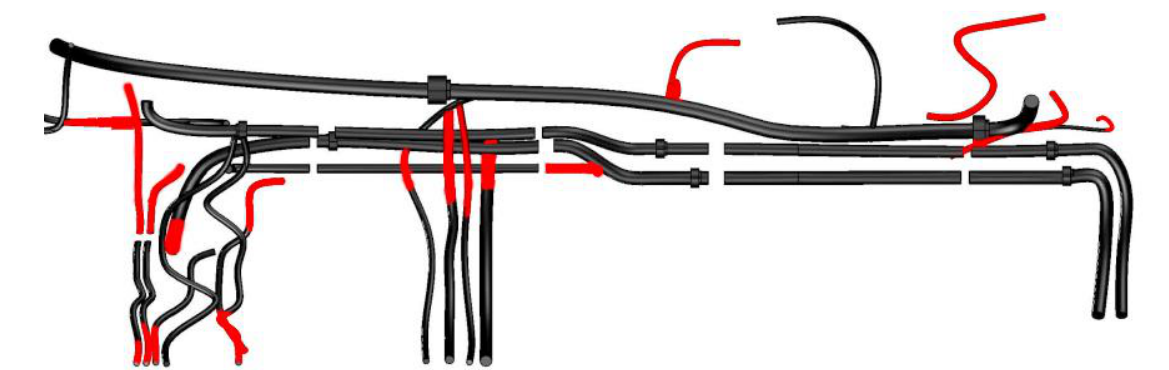
Figure 10. Comparison of the proposed method and canny method.